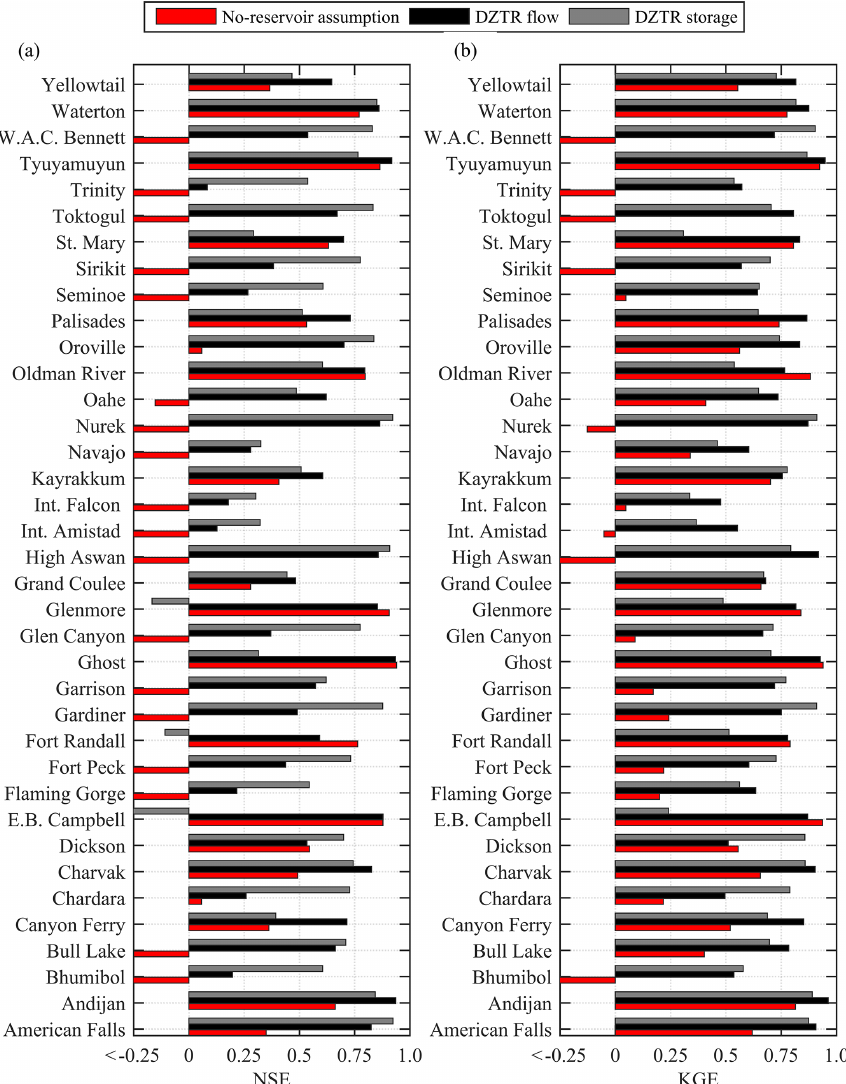
Figure 4. Performance evaluation result of the DZTR model reservoir operation algorithm: (a) NSE performance metrics and (b) KGE performance